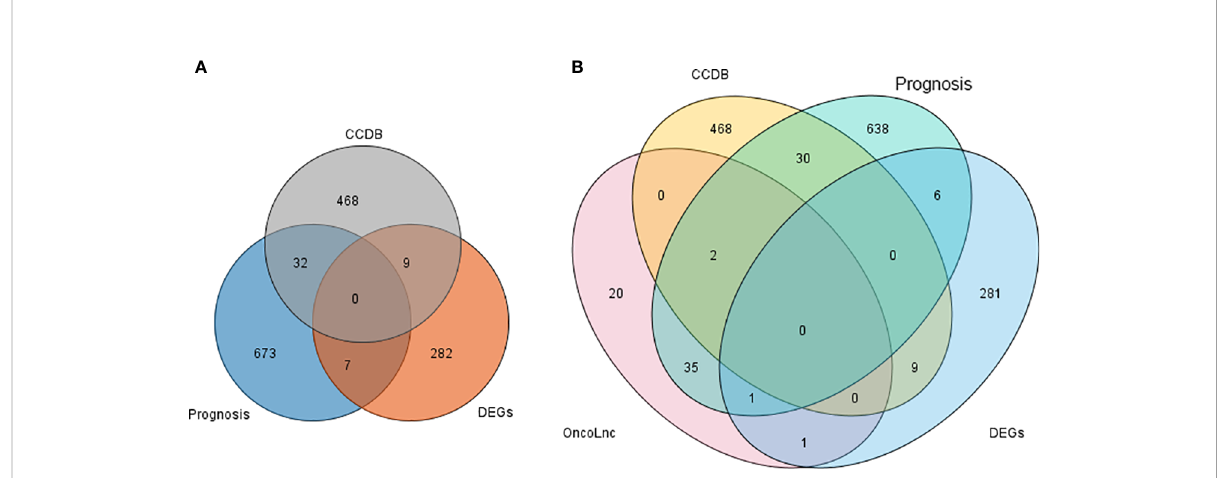
FIGURE 6 (A) Venn diagram ofthree gene database sources. (B) Venn diagram of three gene database sources with OncoLnc.